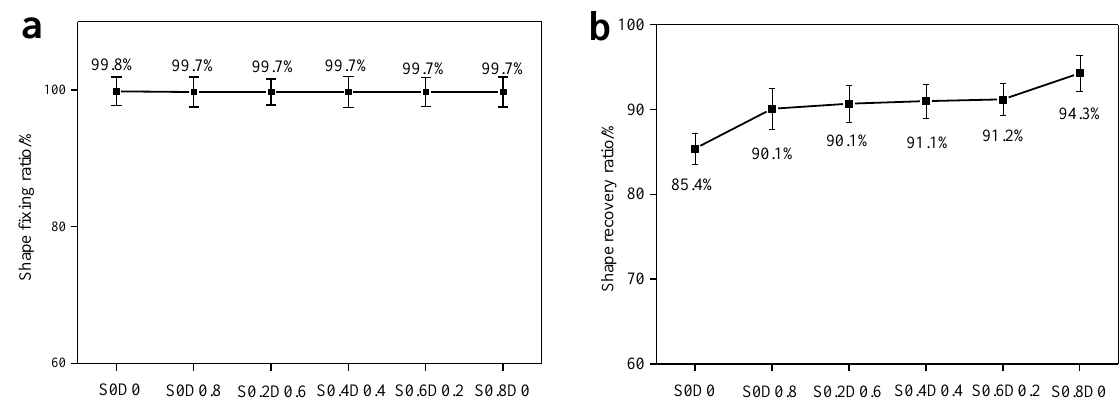
Figure 7. The shape fixation ratio ( a ) and shape recovery ratio ( b ) of PNB (Tg—0 °C–Tg+30 °C).